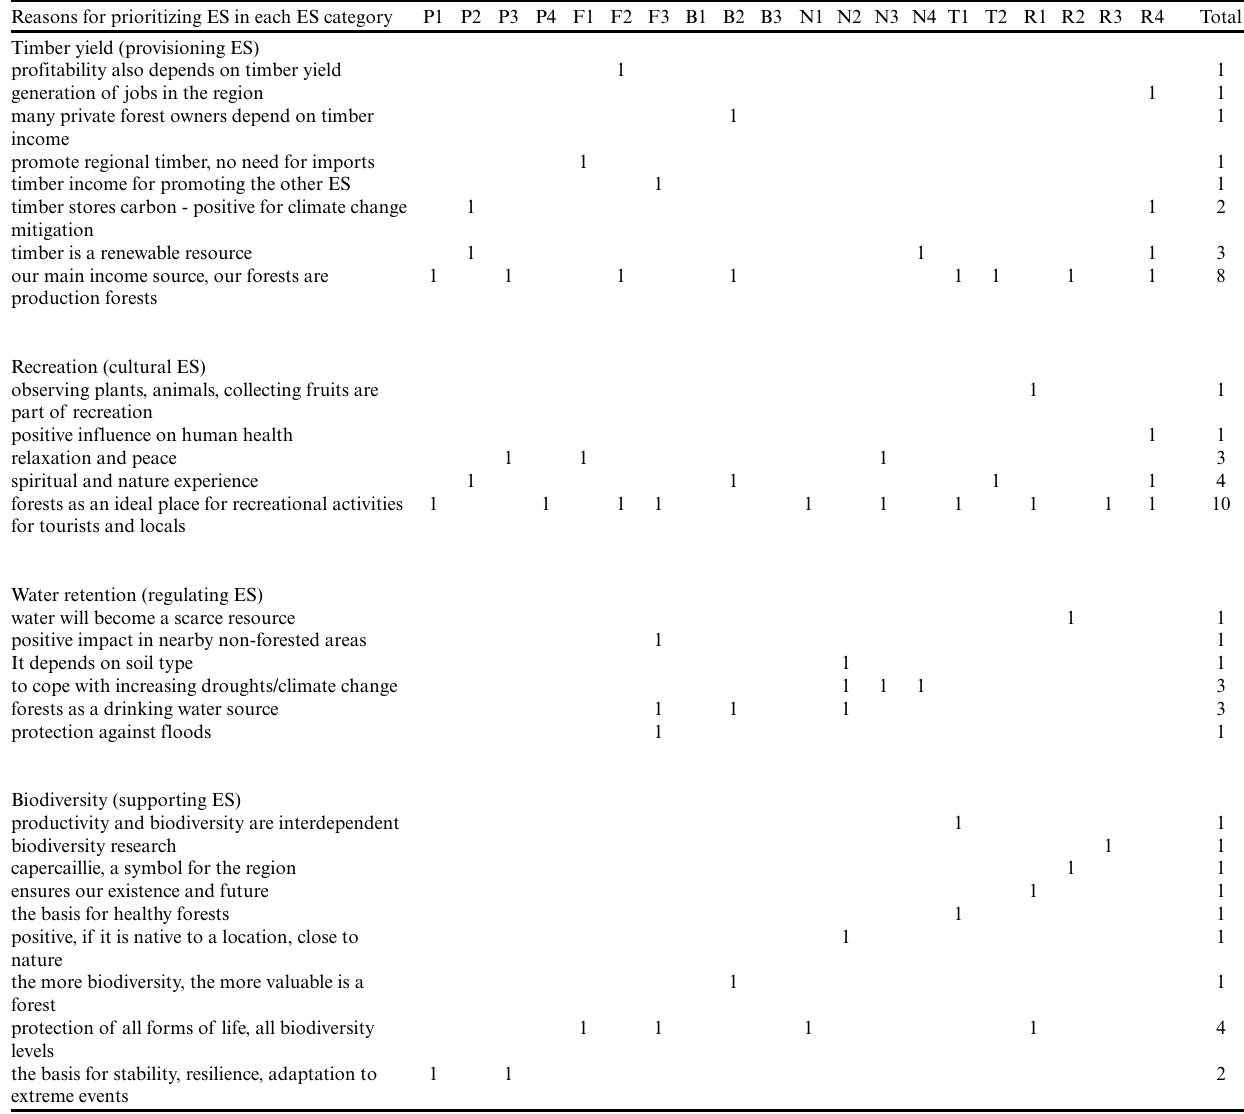
Table 3 . Frequencies of the underlying reasons for prioritizing the ES timber yield, water retention, biodiversity, and recreation. Developed with the tool CodeMatrixBrowser in MAXQDA and based on the code system developed in the same software (Verbi Software